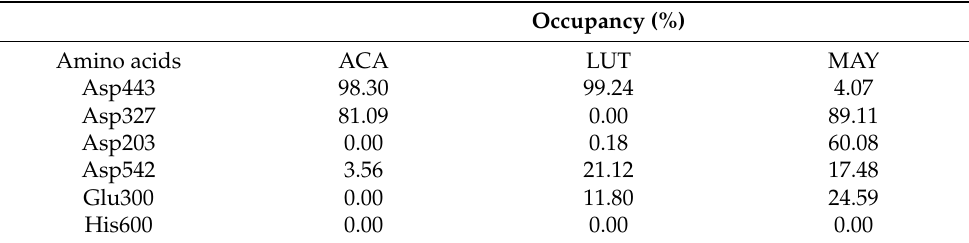
Table 4. Hydrogen bond occupancies of the MD trajectories in ACA, MAY, and LUT with amino acids of the active site.